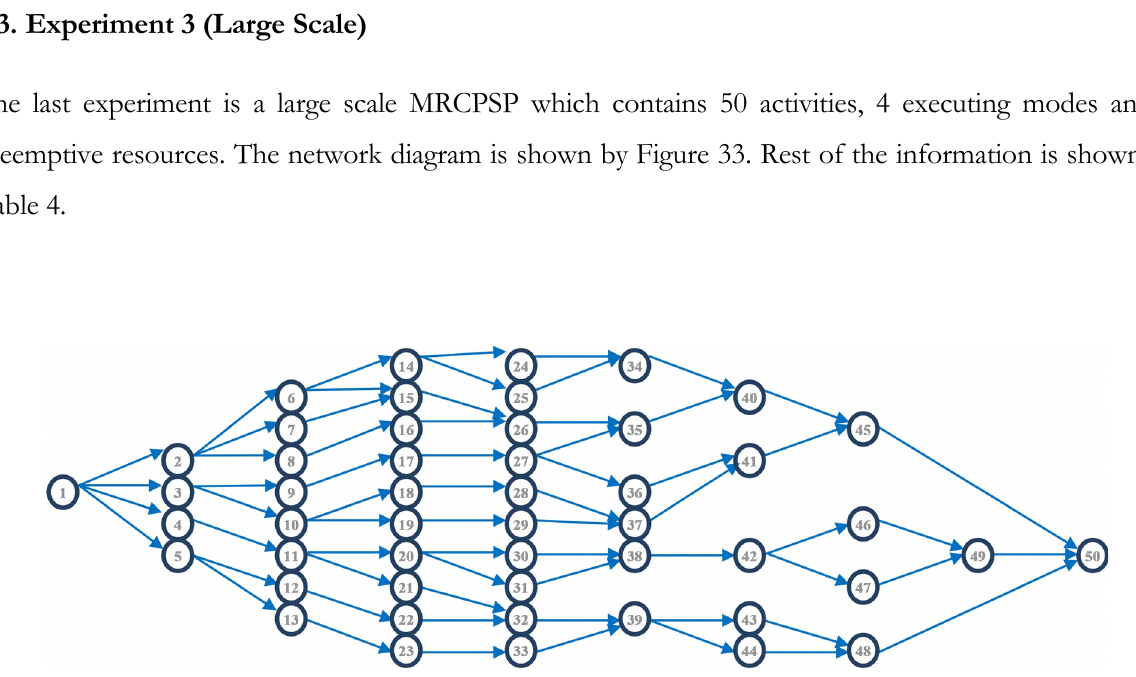
Figure 33. Network diagram of experiment number